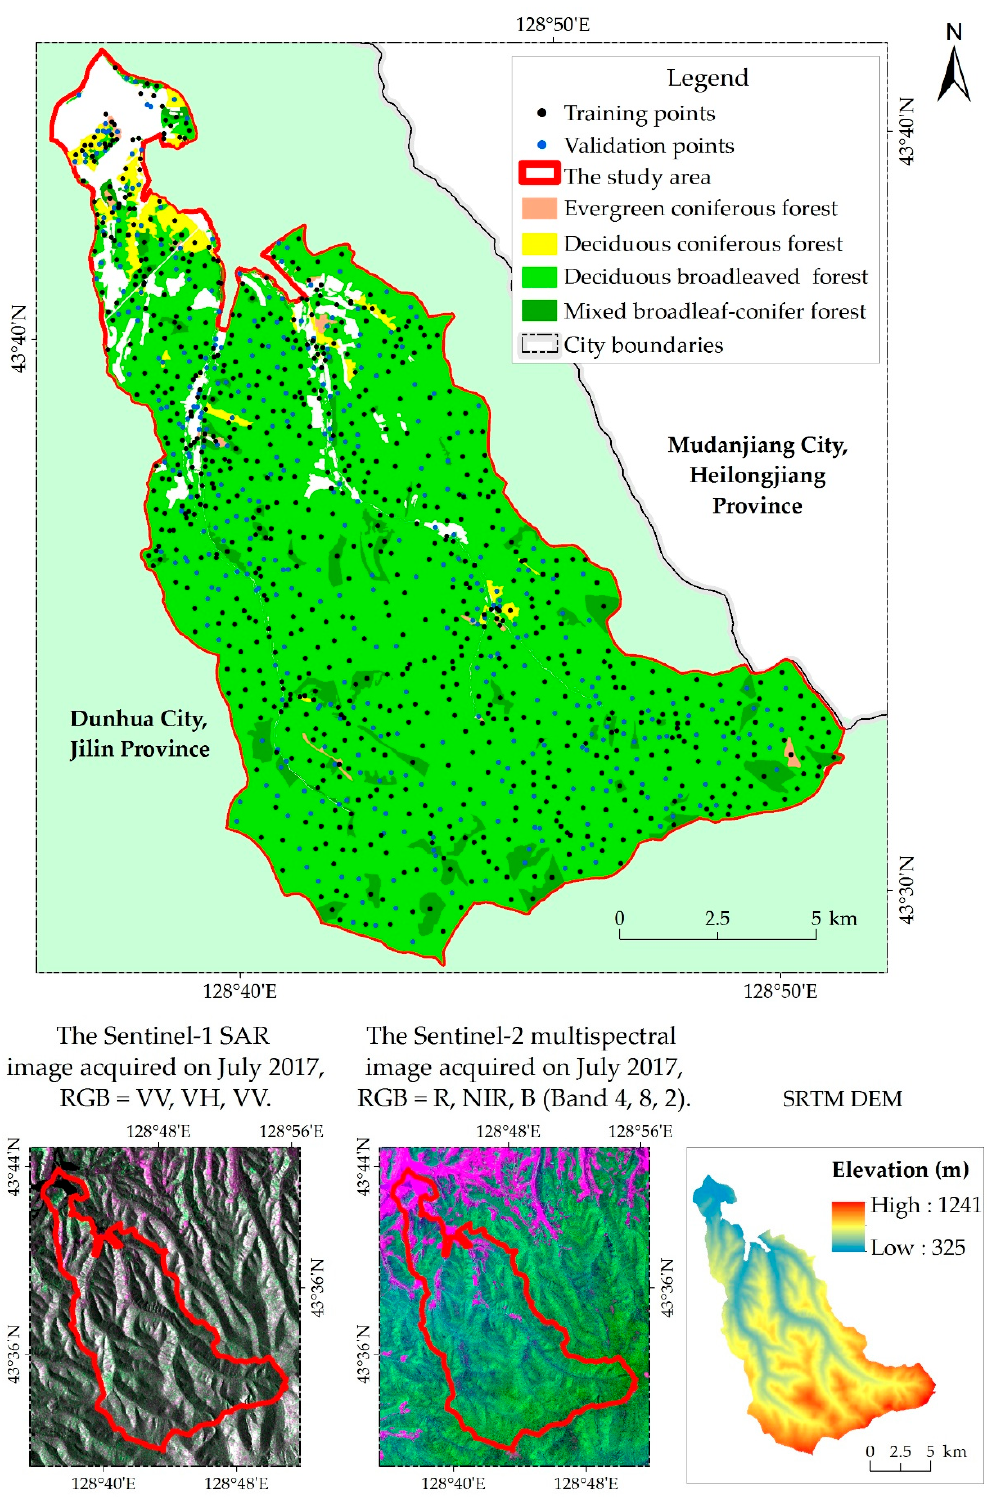
Figure 1. The outline of the study area, sampling sites, and the coverage of Sentinel-1 synthetic aperture radar (SAR), Sentinel-2 multispectral instrument (MSI), and Shuttle Radar Topographic Mission (SRTM) data.